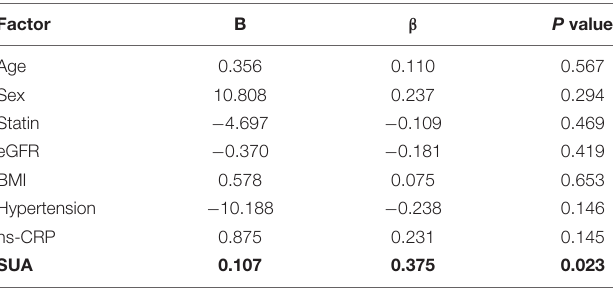
TABLE 7 | Stepwise multiple regression analysis detecting independent contributor to